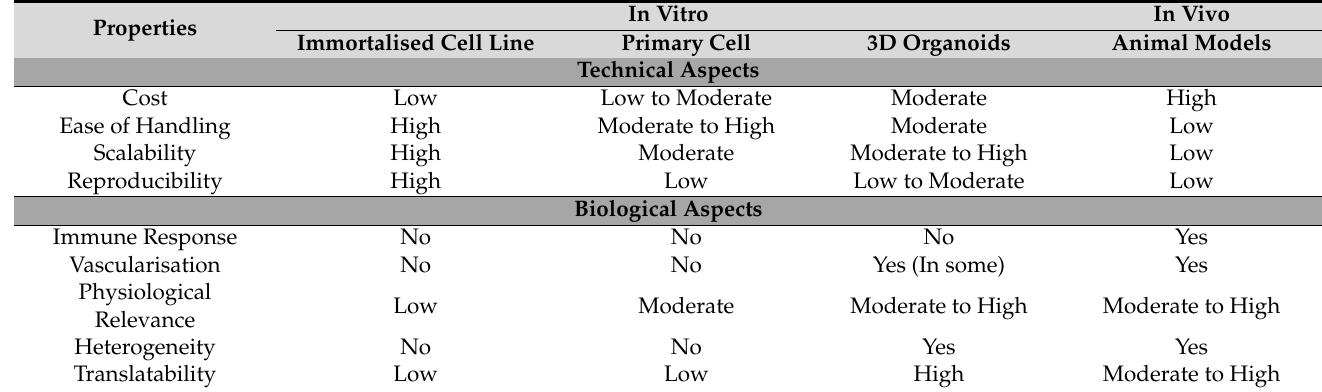
Table 1. Comparison between in vitro and in vivo systems.